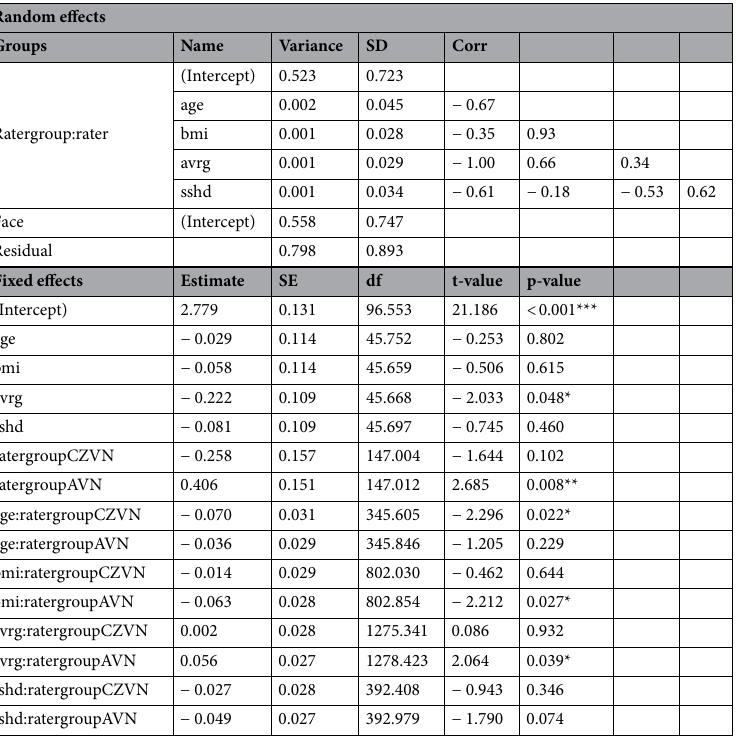
Table 1. Summary of the results of mixed effects modelling for faces of men (female raters). Significance levels: *p < 0.05 **p < 0.01 ***p < 0.001. CZVN Czech Vietnamese, AVN Asian Vietnamese, sshd sexual shape dimorphism, avrg distance from the average, bmi body mass